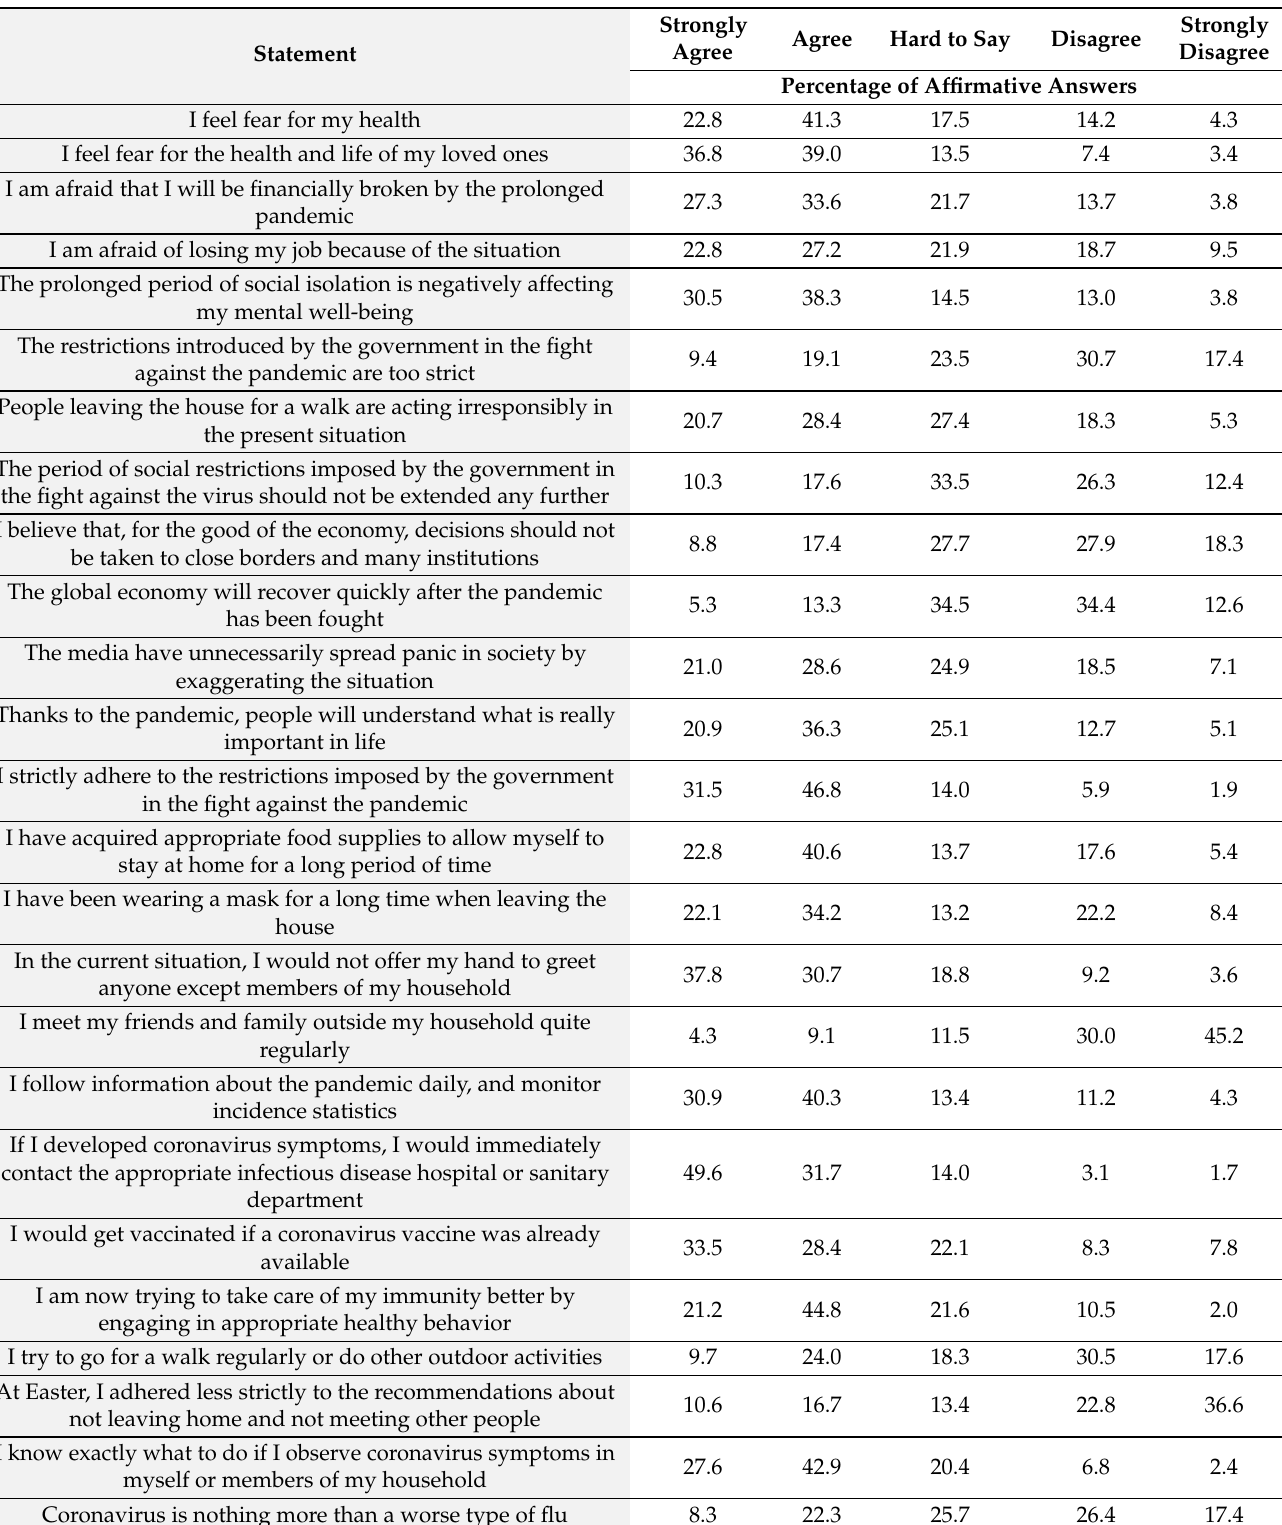
Table A3. Distributions of responses to the statements included in the cluster